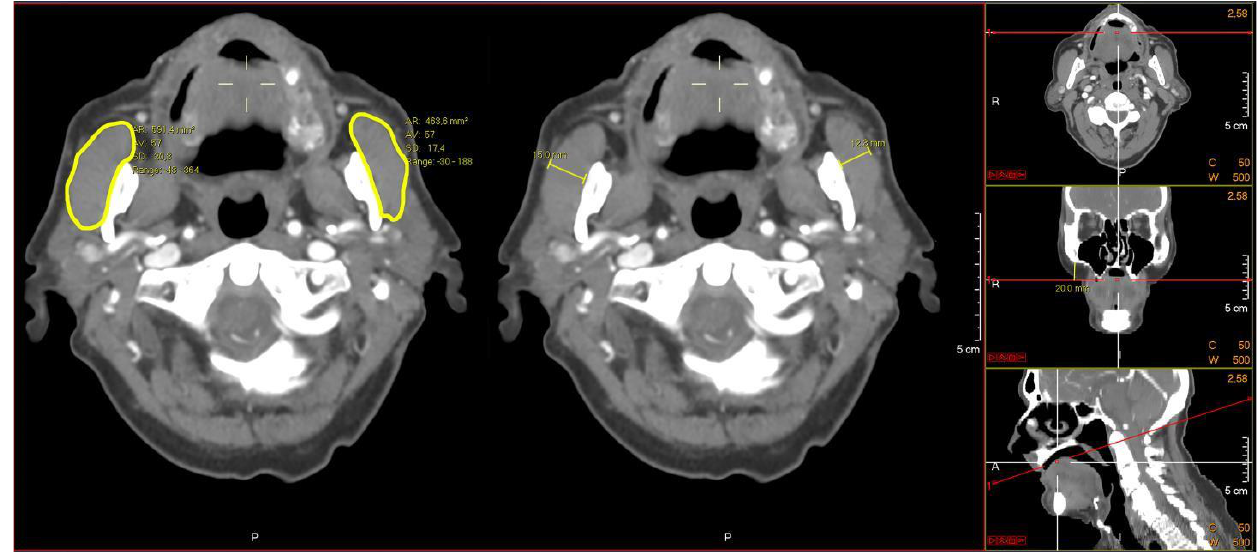
Figure 1. Example of performed measurements of bilateral masseter muscle area ( left ) and thick- ness ( middle ) after tilt adjustments were performed ( right ). ( middle ) after tilt adjustments were performed ( right